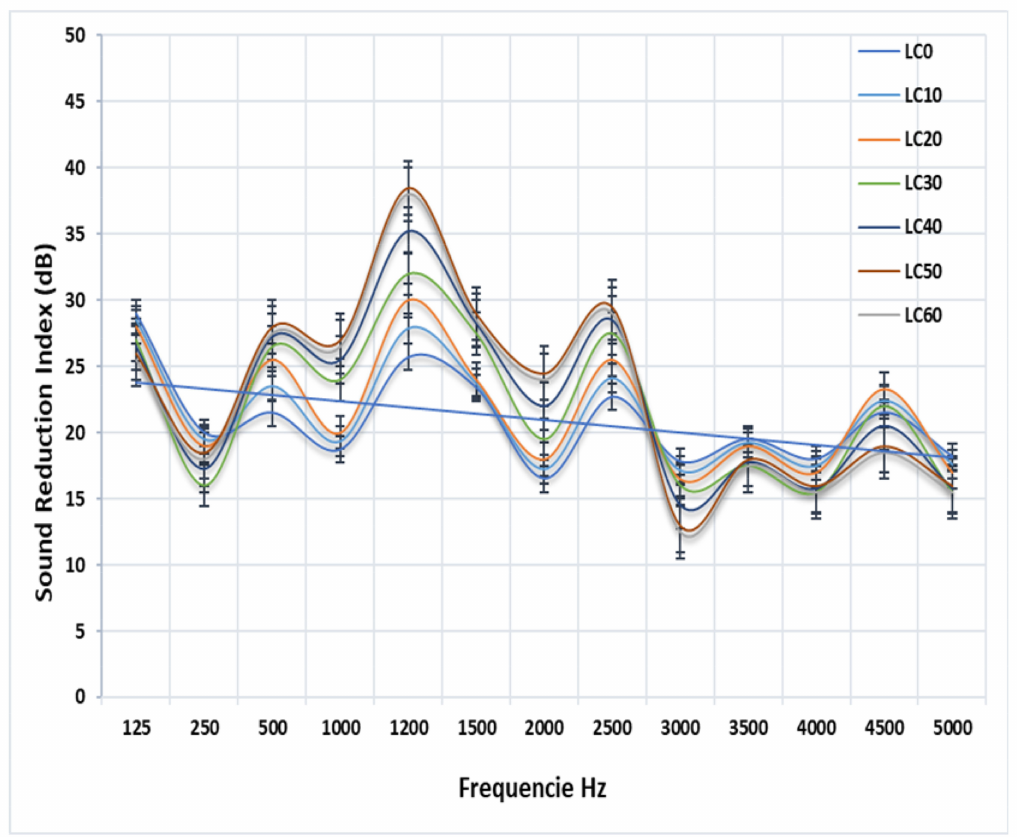
Figure 11. Effect of EPA aggregate dosage on sound reduction index of concrete